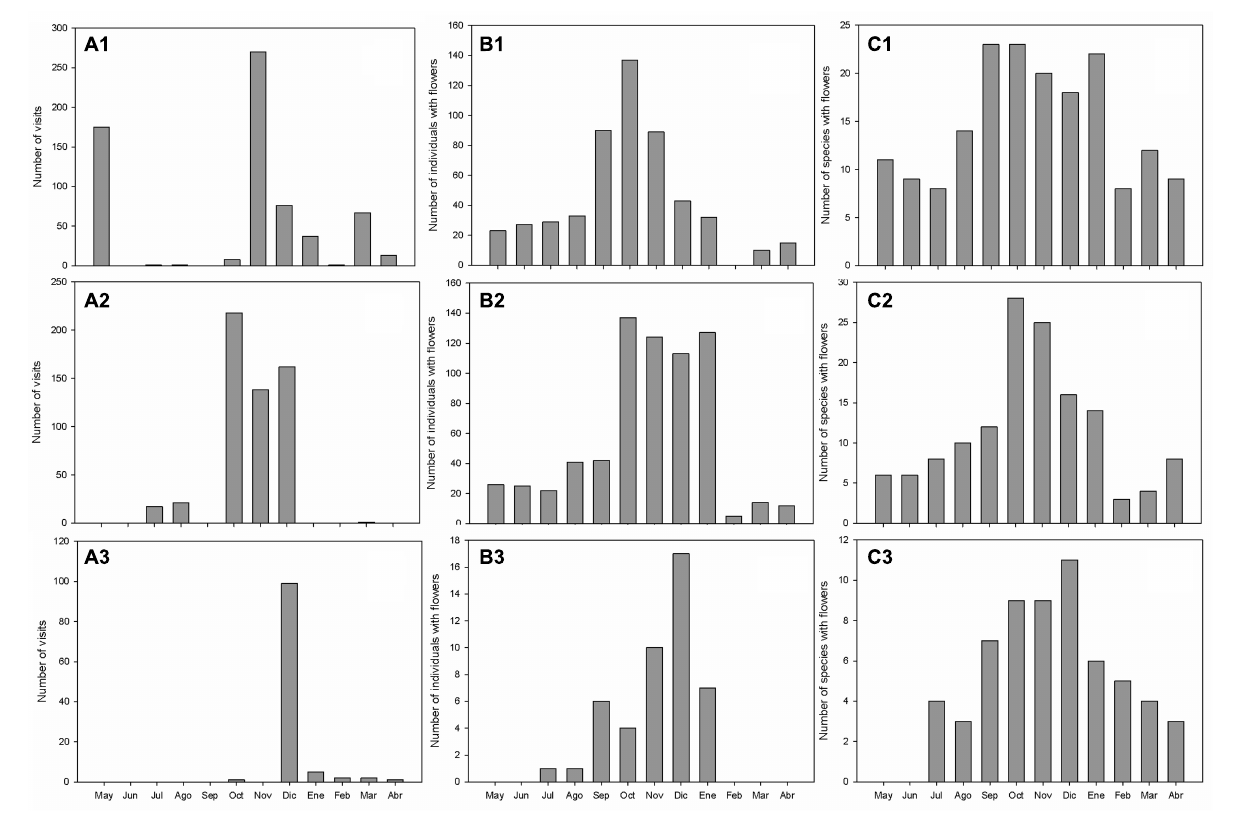
FIGURE 6 | Dynamics of the total number of visits of pollinators ( A1 = PI2, A2 = PB4, and A3 = MO6), total number of individuals with flowers in all the 3 × 3 quadrants ( B1 = PI2, B2 = PB4, and B3 = MO6), and number of species with flowers ( C1 = PI2, C2 = PB4, C3 = MO6) in summits of the GLORIA-Andes network (VE-CPB site), at La Culata National Park, Piedras Blancas Páramo, Venezuela.